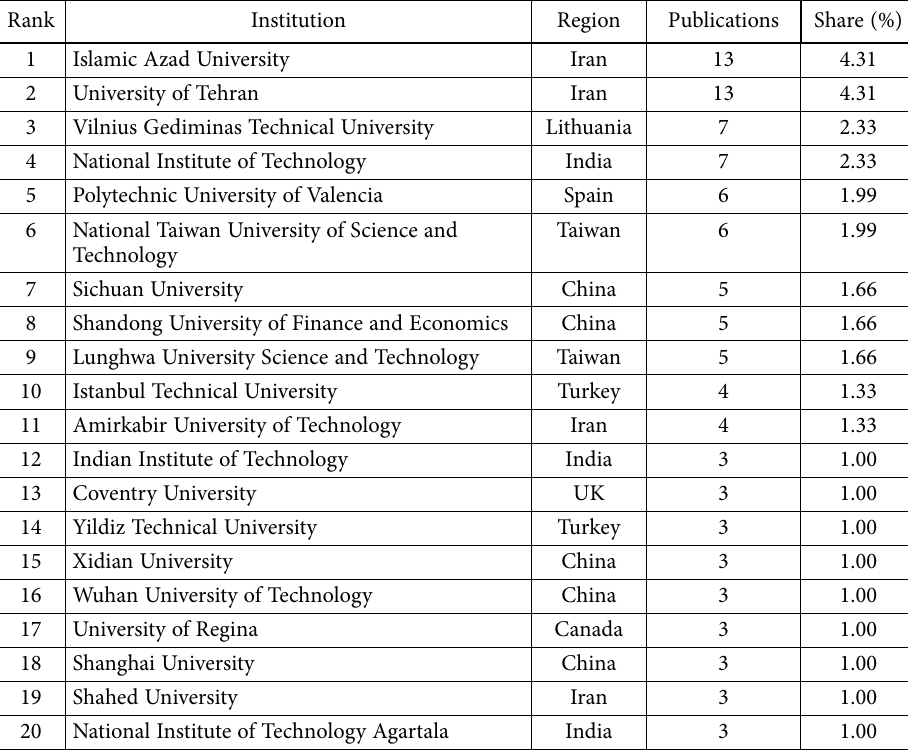
Table 3. Top 20 institutions with most publications